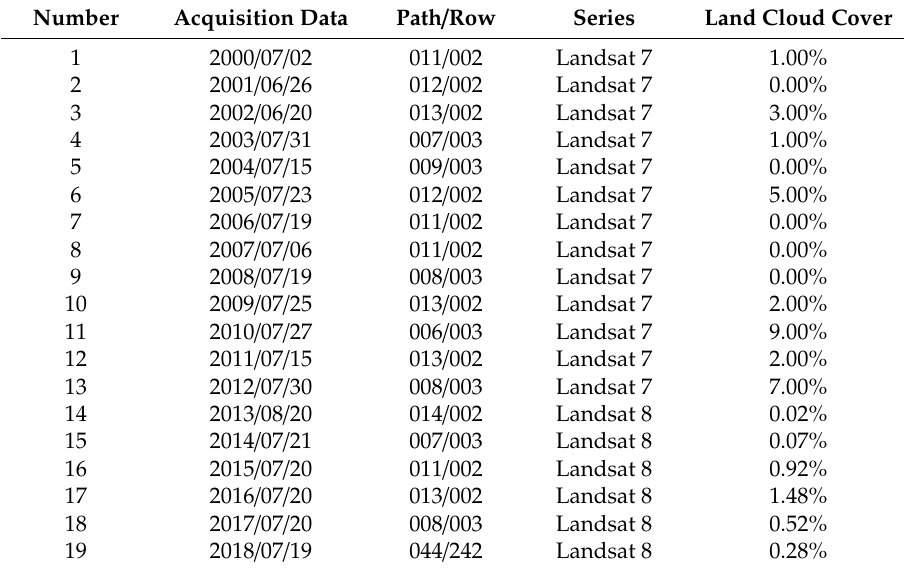
Table 1. Summary of Landsat images used in this